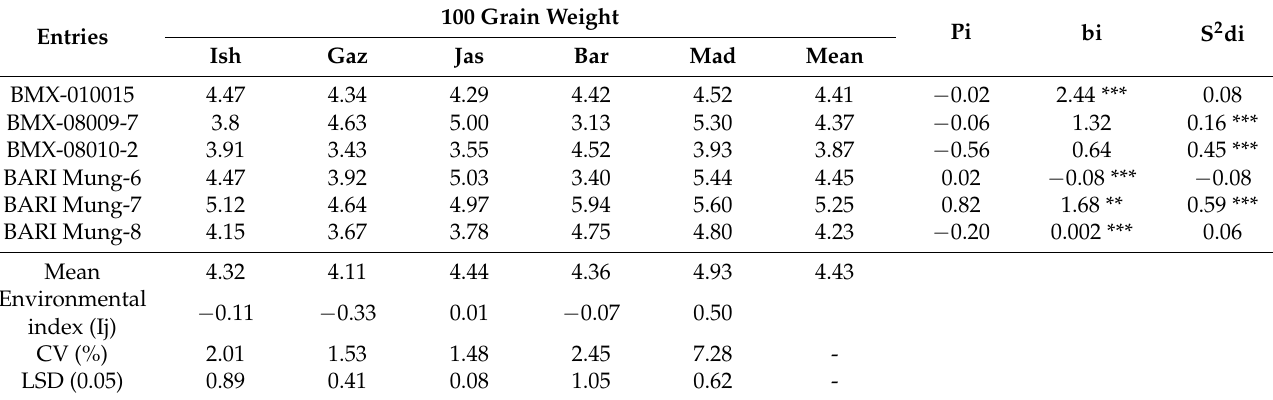
Table 7. Performance of mung bean genotypes for 100-grain weight at different environment studies during summer (Kharif-I) season, 2019. 100 Grain Weight Entries